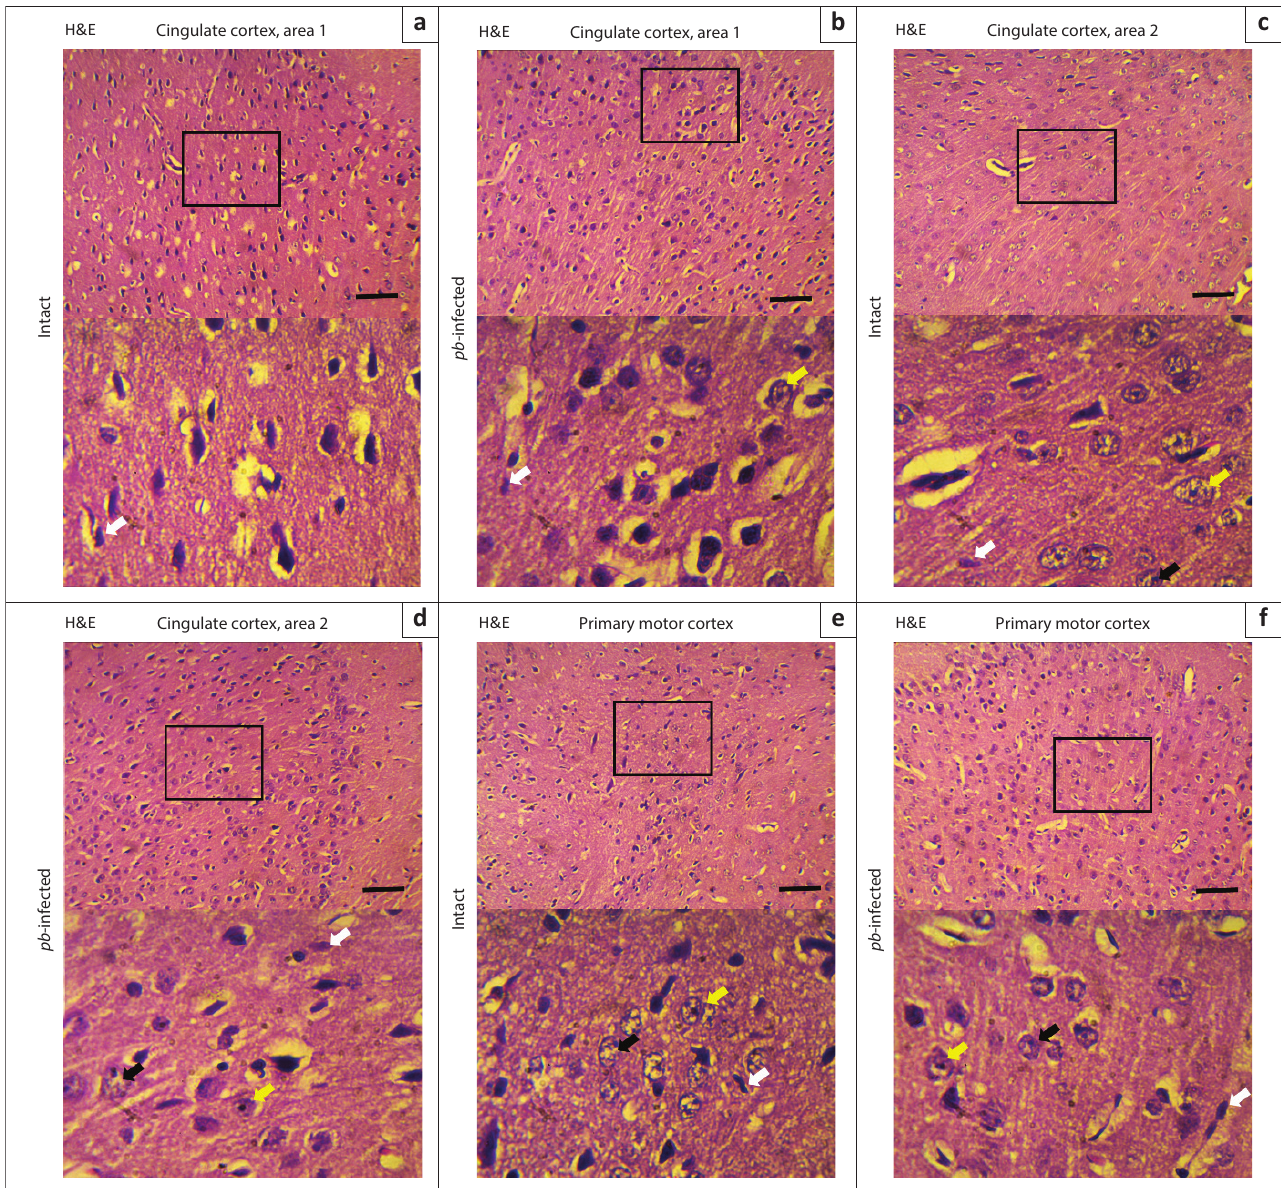
FIGURE 11: Neuronal histochemistry of cerebral cortex. (a) and (b) Haematoxylin and eosin-stained sections of cingulate cortex area 1 in intact and Pb -infected mice, respectively. (c) and (d) Neural cells distribution in cingulate cortex area 2 in intact and Pb -Infected mice, respectively. (e) and (f) Morphology of neural cells at the primary motor area of intact and Pb -infected mice in Haematoxylin and eosin-stained sections, respectively. Despite both Pb -infected and intact mice appeared to have symmetrical cytoarchitecture and cell distribution, several nerve cells appeared fading with centralised nuclei (yellow arrow). There are also few neural cells that appeared ghost-like (black arrow) with peripheral nuclei, yet most of the microglia present (white arrow) are not